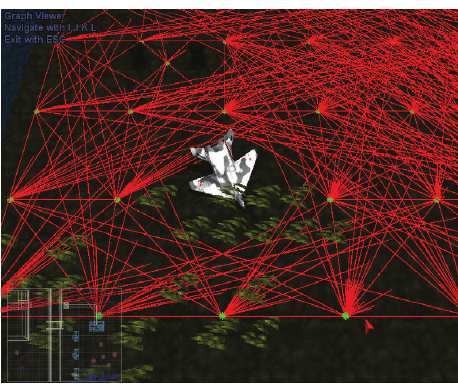
Figure 5: Waypoints placed manually and connections generated automatically.